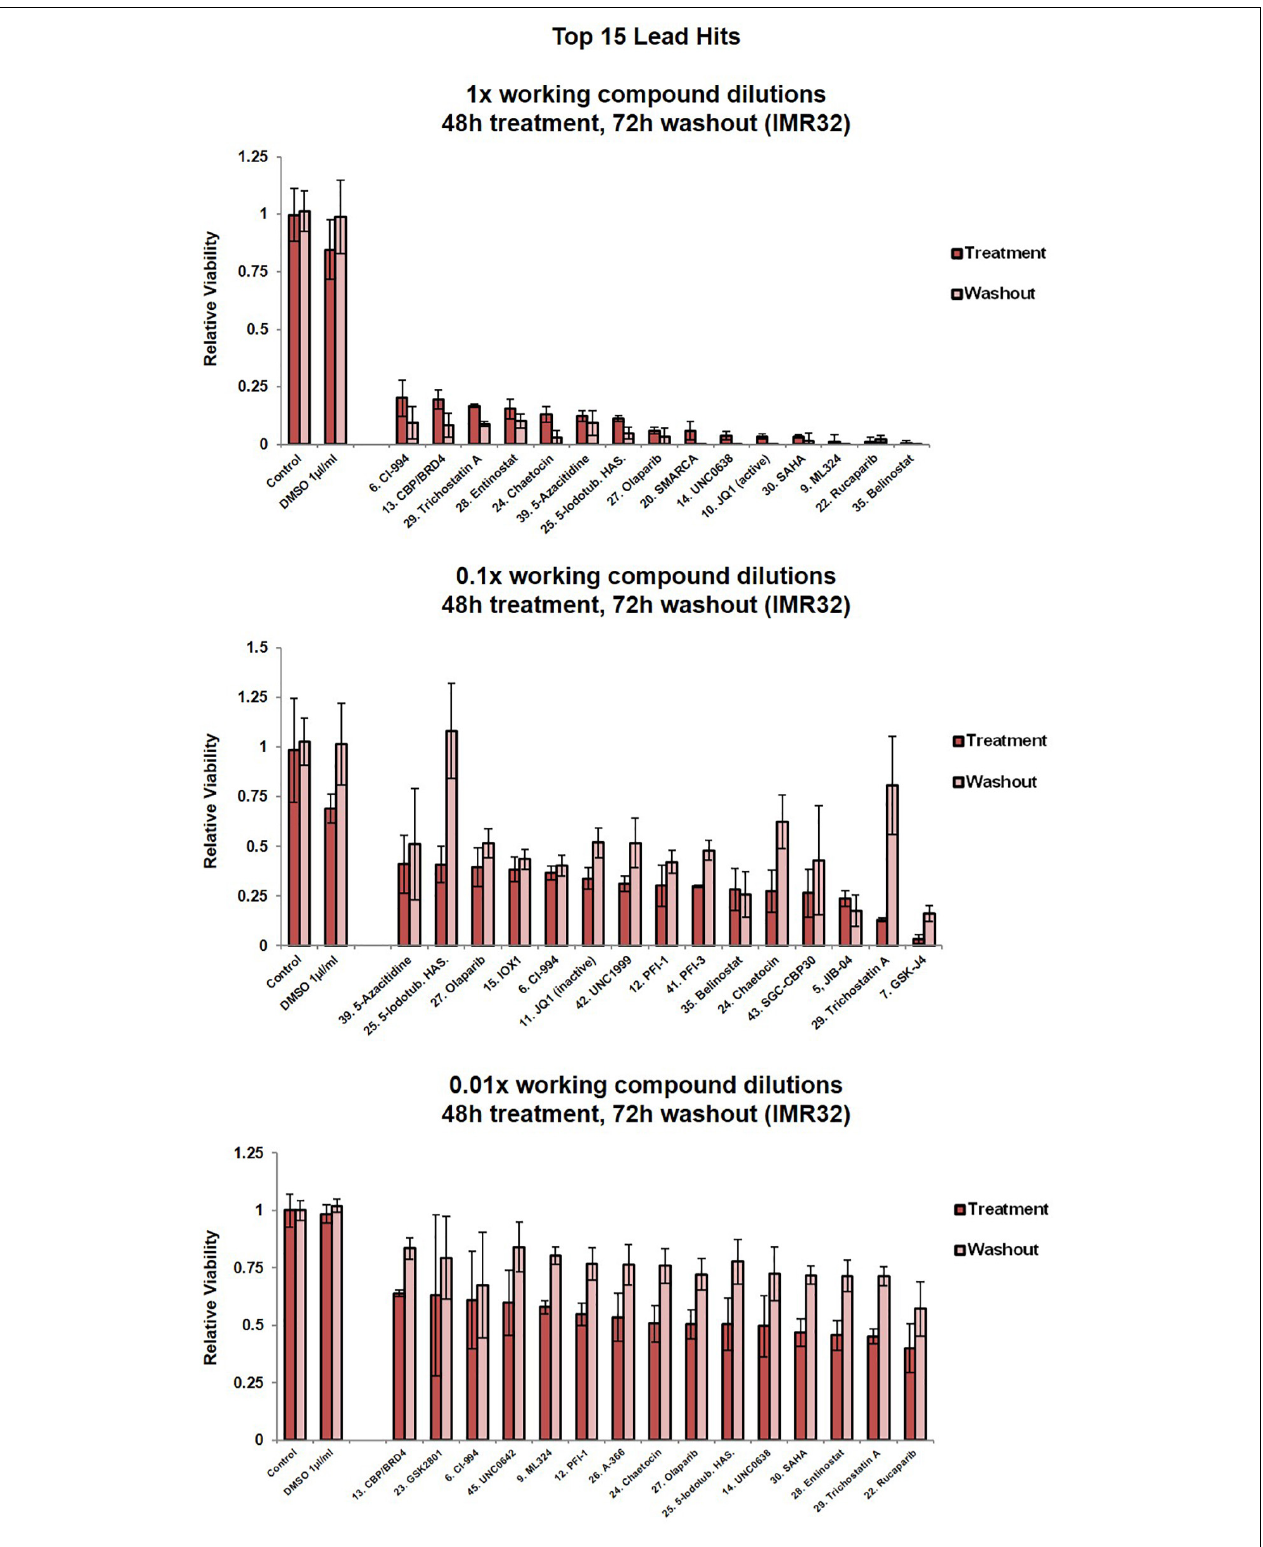
FIGURE 2 | Cell viability assessment for IMR32 cells upon treatment with the top 15 lead SGC library compounds. Compound dilutions are indicated above histograms (1x, 0.1x or 0.01x). Treatment bars – viability upon 48h treatment. Washout bars – viability 72 h upon washout, relative to corresponding untreated control at the same time point. For results from all 45 compounds in the library please see Supplementary Figure 1C . Error bars indicate the mean ± SD.